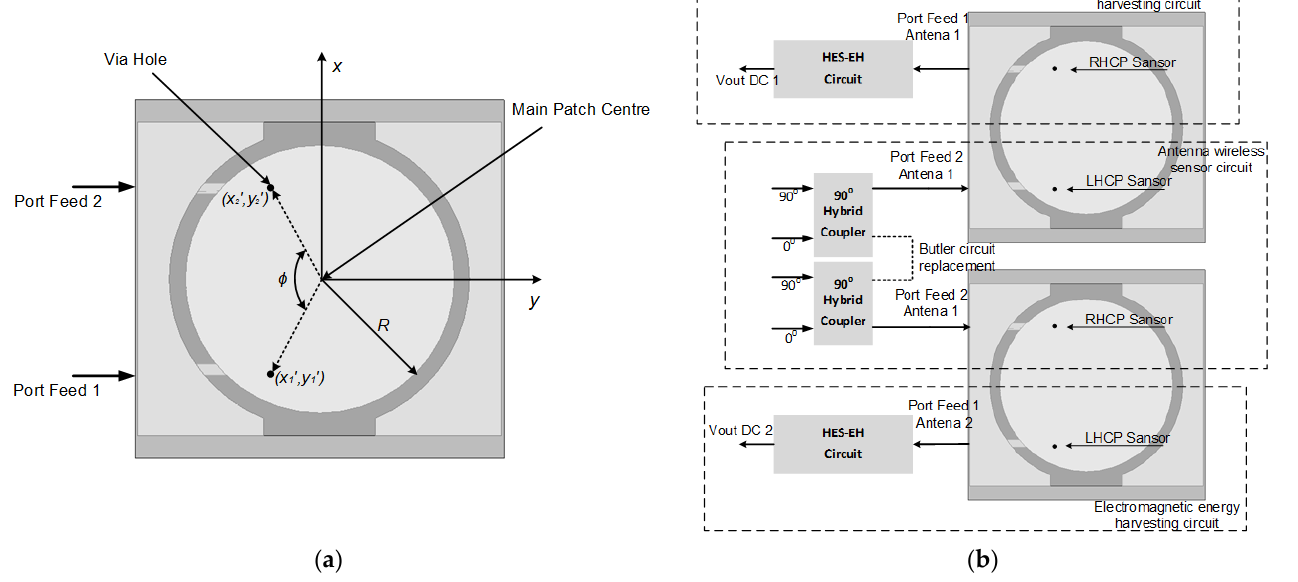
Figure 3. ( a ) Arrangement via the hole on transmission feed ( b ) Feed transmission on CP antenna configuration. The value in Formula (1) of Qt = 1/tan δ , and the k = ( k y − k x ) − Qt . Tan δ is the loss tangent of the material. Based on the optimization, the angle ϕ separates the two via holes is determined. It is obtained to produce an orthogonal field to each other under the patch and outside the patch. The via hole is positioned at the point where the other via-hole generates the field; therefore, the reducing effect significantly changes the performance between ports to increase the antenna’s sensitivity to wave polarization [15]. The ground plane separating the primary patch connection and the double U slot is smaller than the resonance size so that radiation has propagated to the main patch element. Assuming the circular patch resonates in its dominant mode, the accumulation of the slot optimization model concerning the frequency formed on the patch surface is expressed in Equation (2).